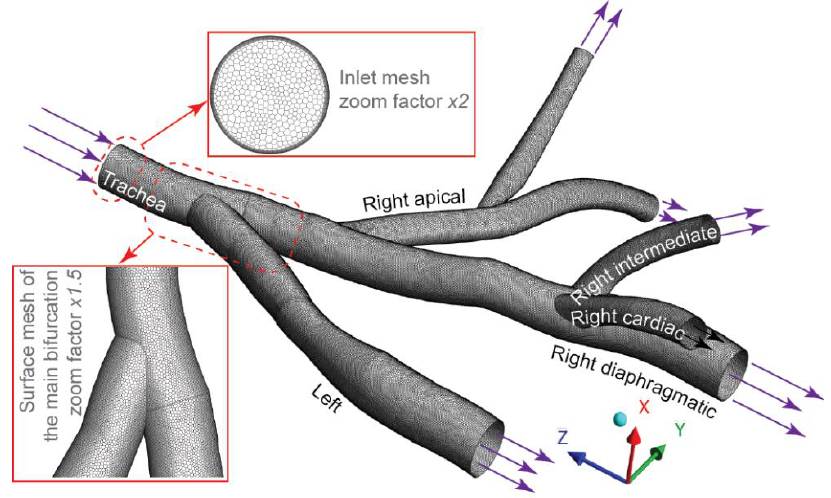
Figure 1. The rat lung airway model constructed from previous morphometric study [27].